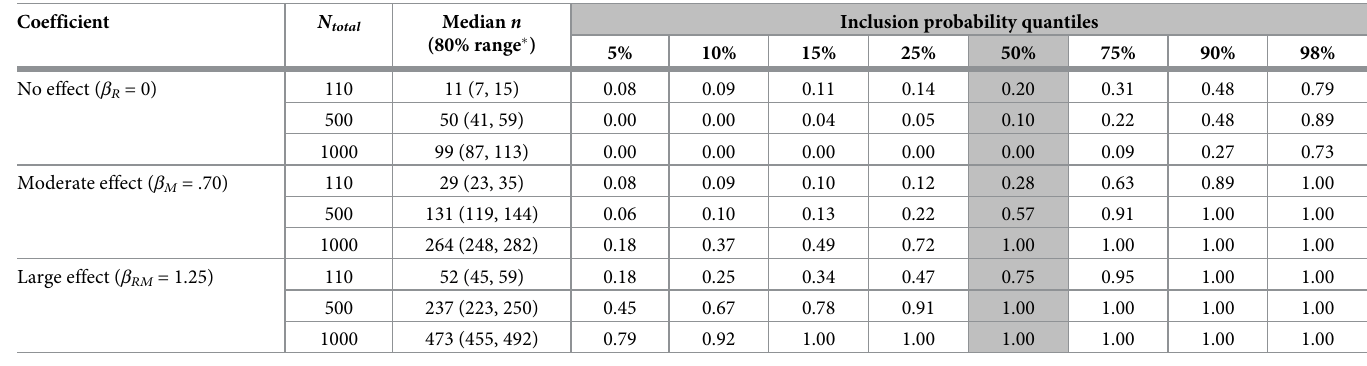
Table 14. Inclusion probabilities of coefficients of interest from the simulation study. Each sample size consisted of 1000 simulations. Cell sample size ( n ) differs between simulations based on the probabilities in Table 12. Coefficient N